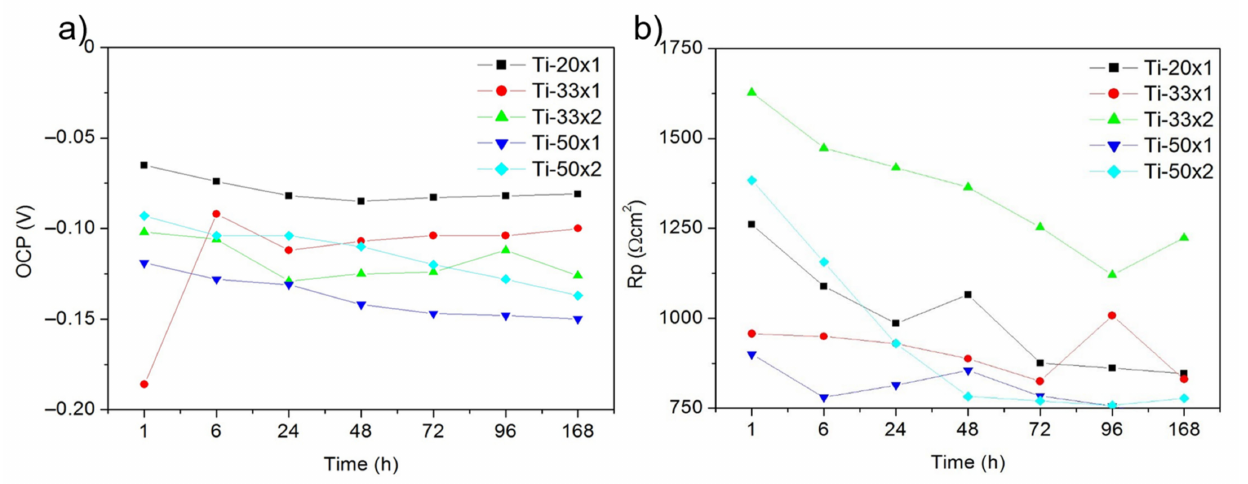
Figure 11. OCP of each specimen measured along a week ( a ); and Rp of each specimen measured during a week of immersion in 3.5% NaCl ( b